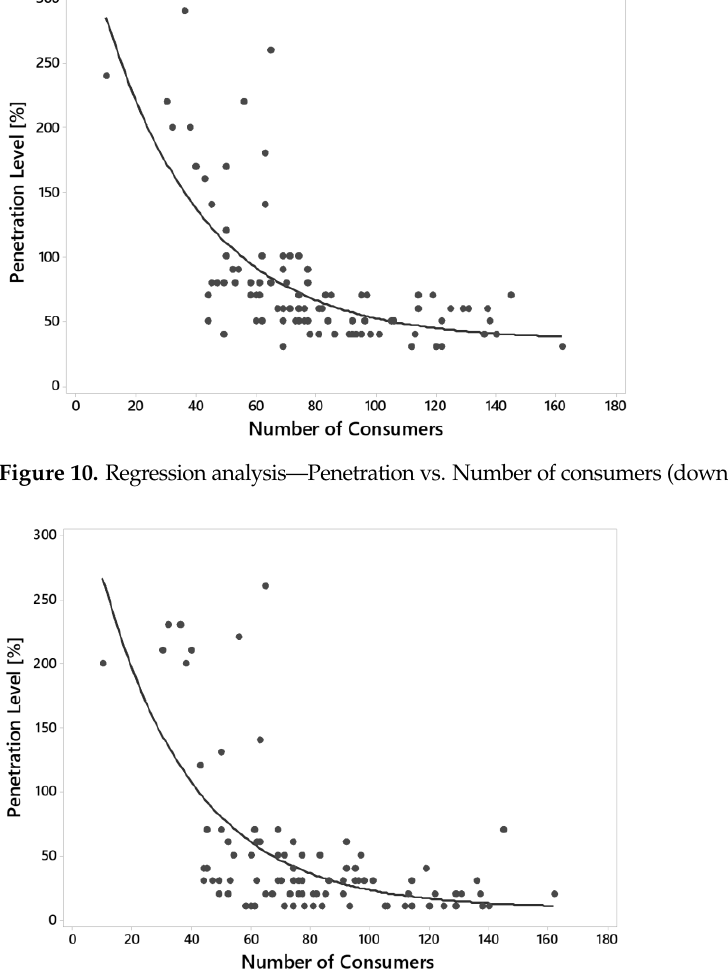
Figure 11. Regression analysis—Penetration vs. Number of consumers (upstream allocation sce- nario).